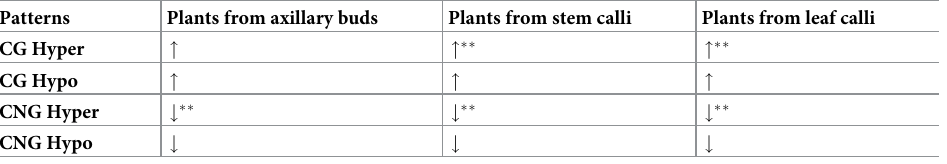
Table 6. Locus-specific MSV in ex vitro plants from axillary buds, stem calli and leaf calli compared with that of the corresponding in vitro plants of L . ruthenicum .